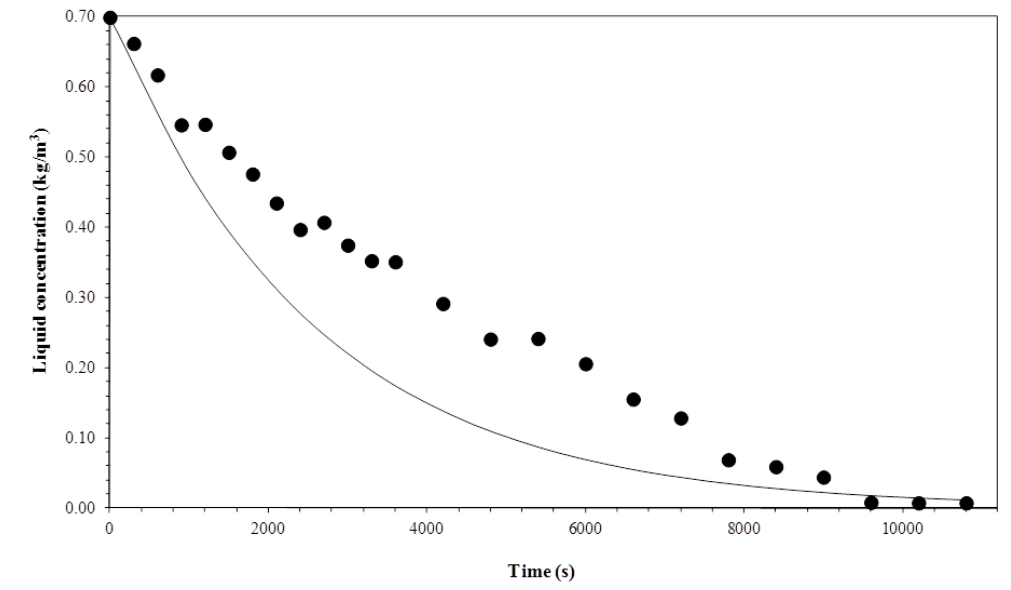
Figure 12. Comparison between experimental data and the model for a gas flow rate of 3.3 × 10 − 7 m 3 s − 1 and temperature of 35 °C.